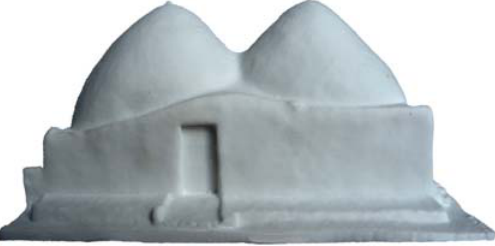
Figure 11. Solid model of dwelling units in the village of Er Raheb (Syria) – sinterized